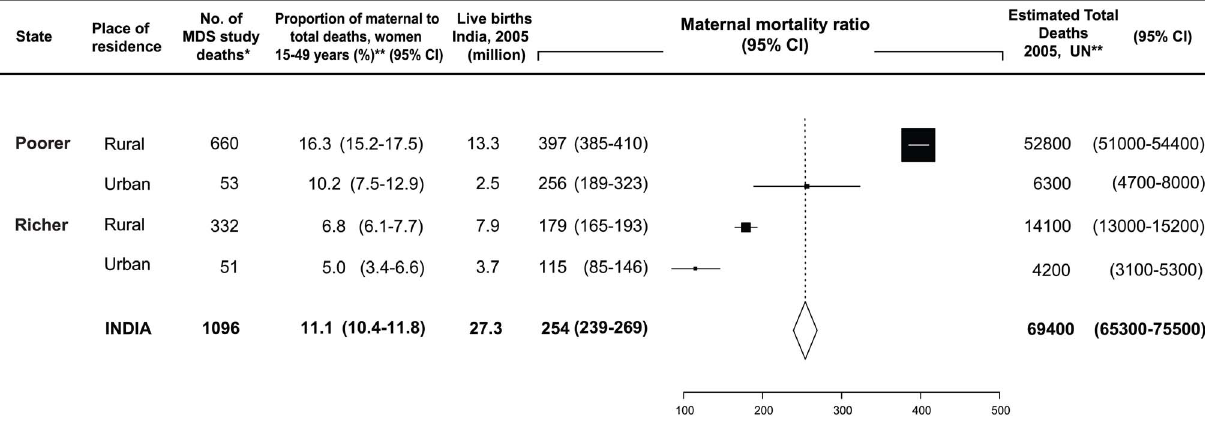
Figure 1. 2005 estimated proportion and number of maternal deaths by region. Datasource: SRS 2001–3, SRS 2004–6 MMR and UN live birth and death estimates for India 2005 * Unweighted sample count of maternal deaths ** Survey weighted, (95%CI), rounded to nearest 100th. MDS - Million Death Study. Low-income states Bihar, Jharkhand, Madhya Pradesh, Chhattisgarh, Orissa, Rajasthan, Uttar Pradesh, Uttarakhand and Assam.